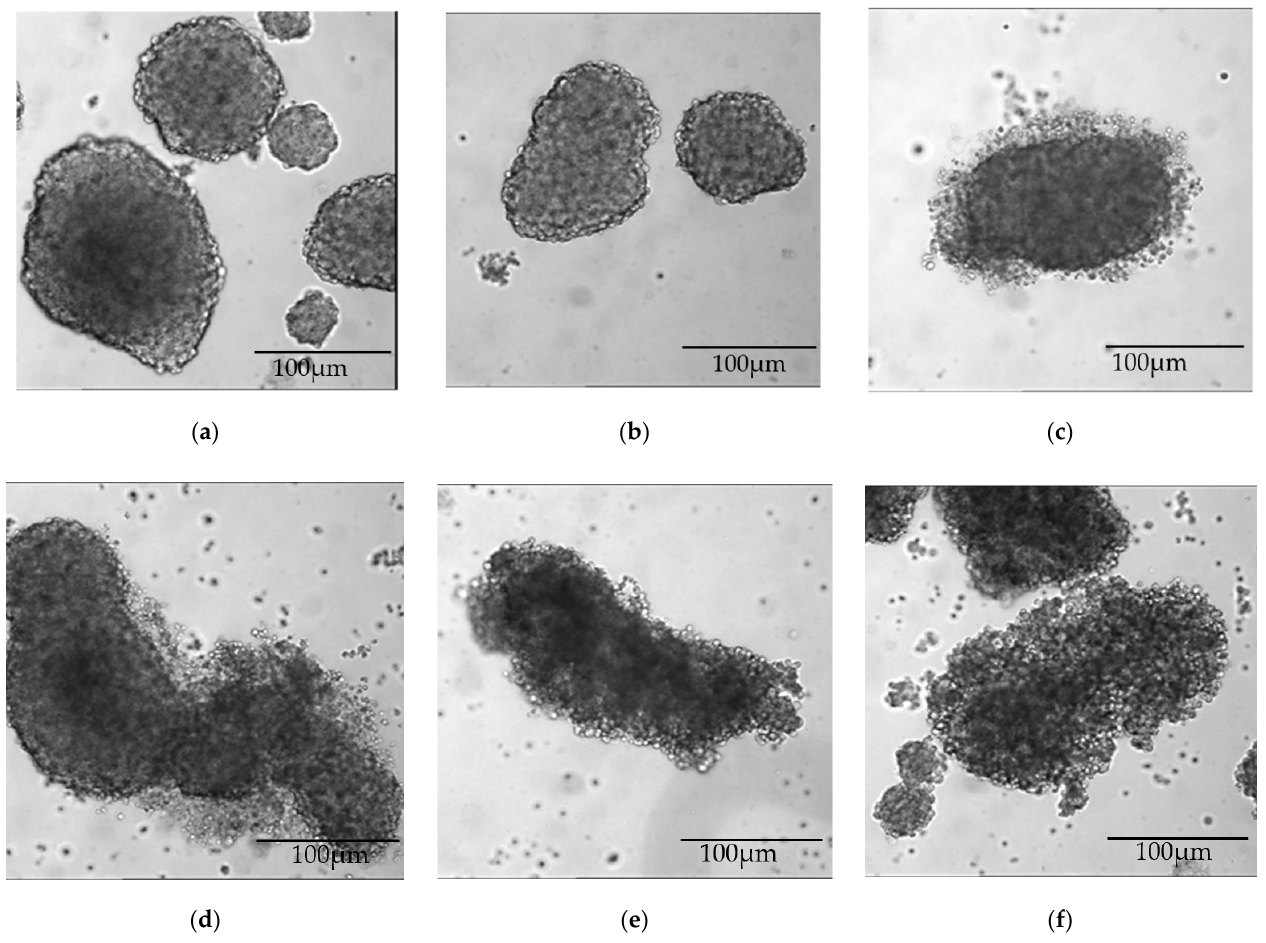
Figure 3. MSTO-211H sph. after 48 h treatment with increasing doses of GP-2250: ( a ) control, ( b ) 500 µmol/L, ( c ) 1000 µmol/L GP-2250, ( d ) 1500 µmol/L GP-2250, ( e ) 2000 µmol/L GP-2250 and ( f ) 2500 µmol/L GP-2250. Similar to JL-1 sph., GP-2250 had a microscopic effect on the spheroid periphery by loosening cell–cell contacts. A dense spheroid core can still be identified wherein single cells cannot be distinguished.